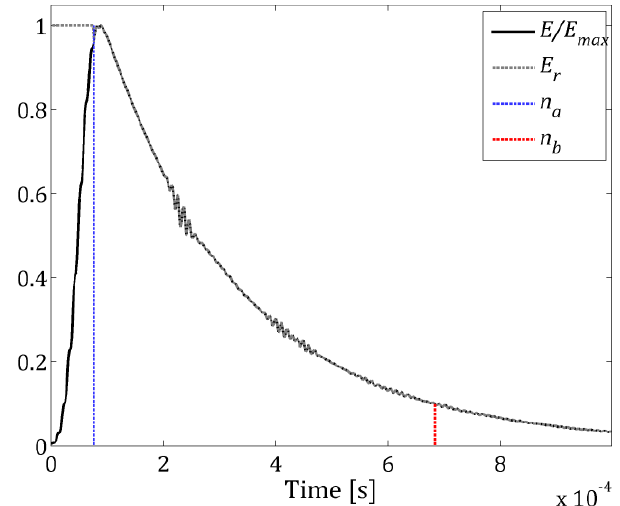
Figure 2. Normalized Guided Waves (GW) energy function E/E max and attenuation compensation function E r .